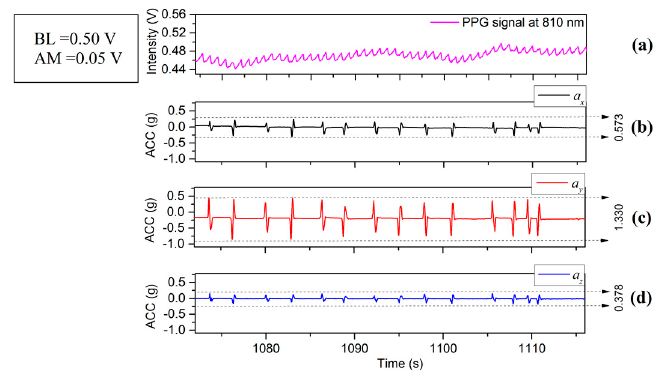
Figure 3. ( a ) PPG and ( b – d ) ACC signals with the main motion acceleration in Y -axis.